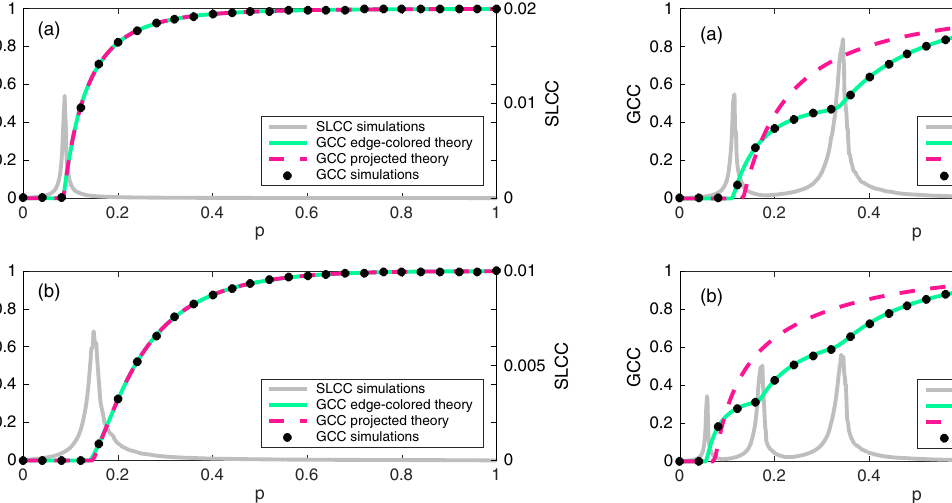
FIG. 2. Expected size of the GCC as a function of p for (a) a two-layer multiplex network made of two Poisson random networks and (b) a three-layer multiplex network made of three Poisson random networks. Both networks are highly anticorre- lated. Numerical simulations are averaged over 100 realizations, N ¼ 10 5 , and the overlap has 100 nodes. Peaks in the expected size of the SLCC indicate percolation transitions.